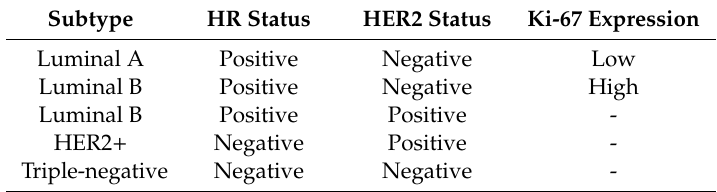
Table 1. Clinicopathological classification of breast cancer